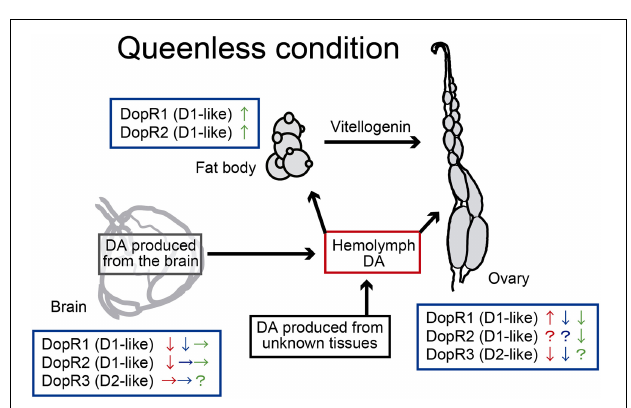
FIGURE 3 | Gene expression of dopamine receptors in the brain and peripheral tissues of reproductive workers. Red: Apis mellifera , blue: Harpegnathos saltator , green: Diacamma. sp. The expression levels of receptor genes are based on Vergoz et al. (2012); Penick et al. (2014), and Okada et al. (2015). In this summary, “queen” and “queenless” are used in a broad sense to include functional queens in ants (i.e.,